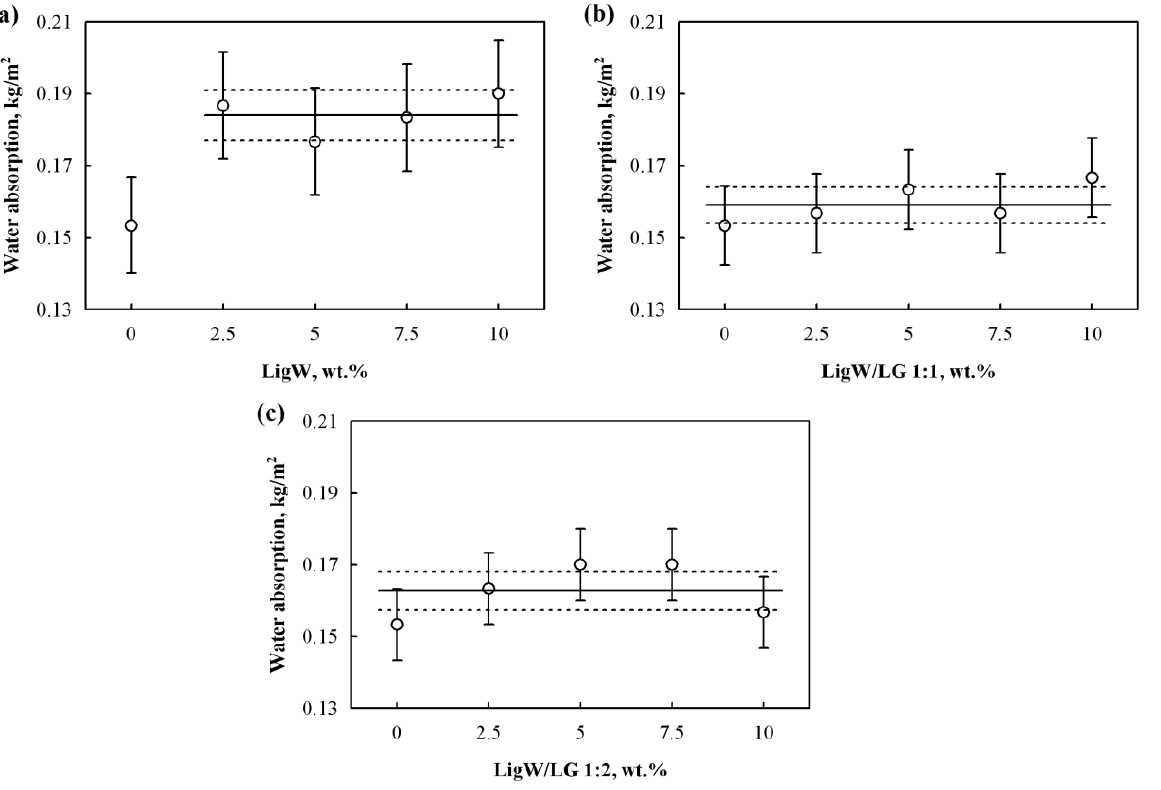
Figure 8. Short-term water absorption of bioPUR foams with: ( a ) LigW particles; ( b ) LigW/LG 1:1 particles; ( c ) LigW/LG 1:2 particles.